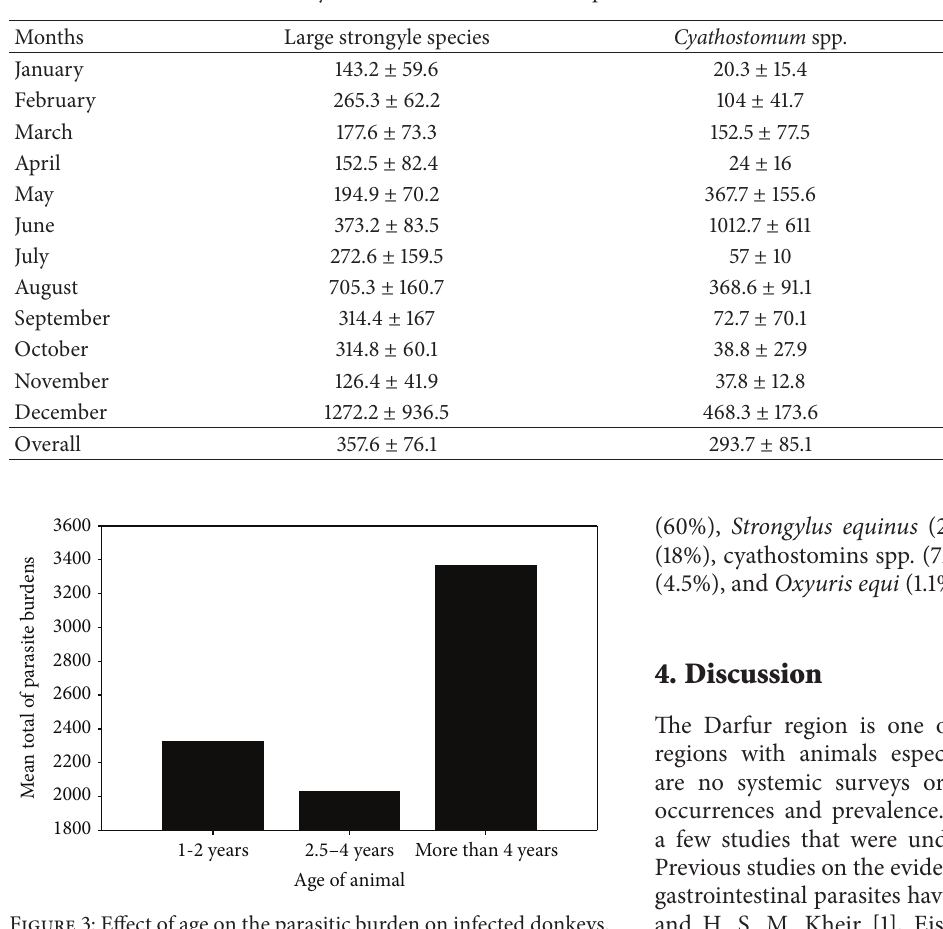
in the current survey. They are Habronema muscae (56%), Habronema microstoma (37%), and Habronema megastoma (7%), Trichostrongylus axei (30.4%), Parascaris equorum (22.8%), Anoplocephala perfoliata (15.5), Strongylus vulgaris